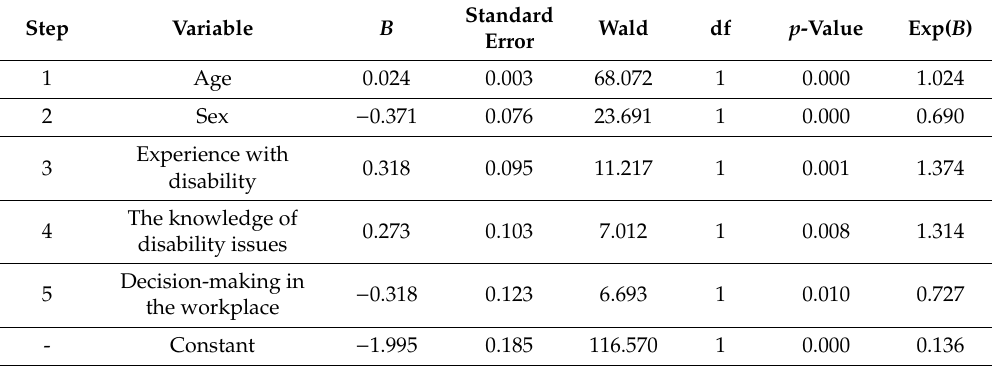
Table 7. Results of multivariate logistic regression—variables in the